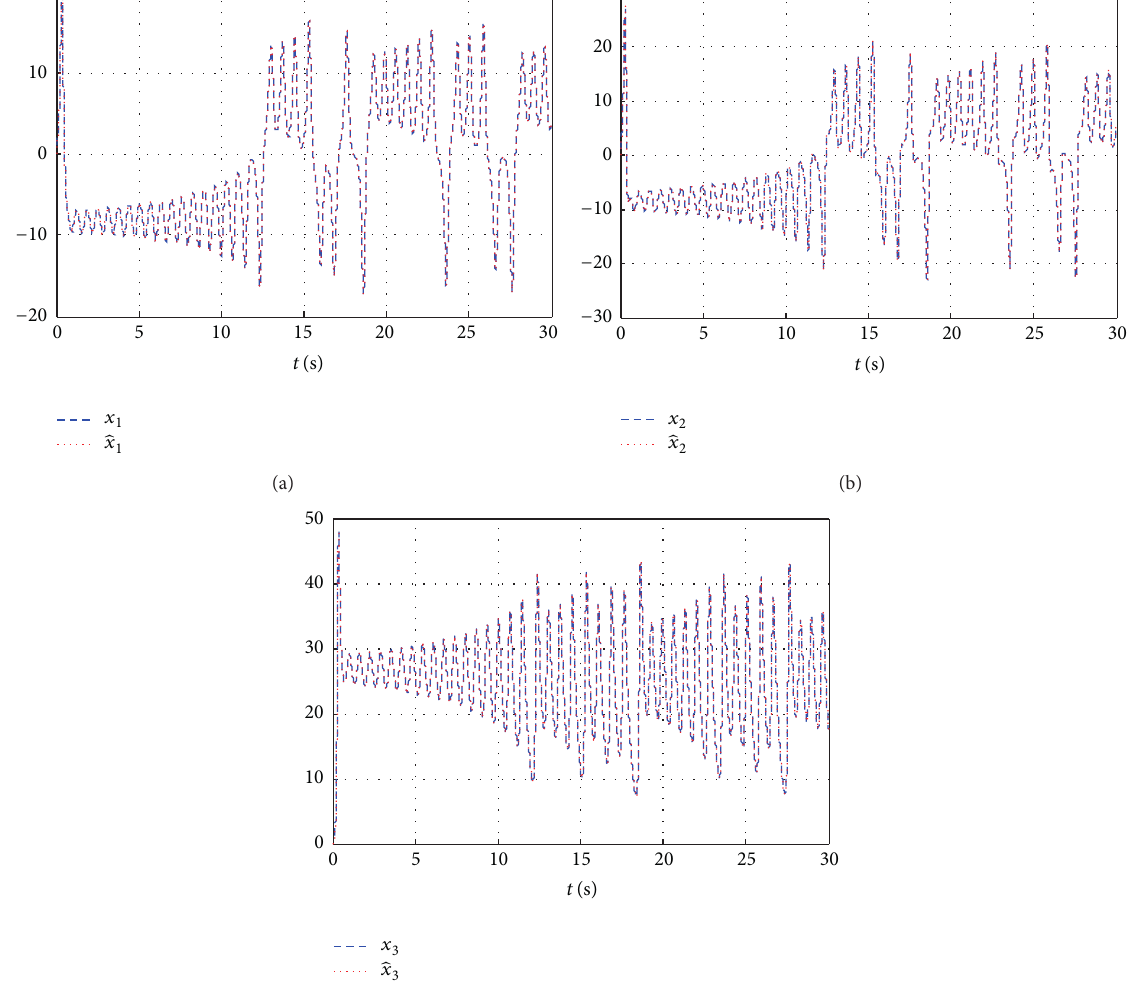
with the initial conditions 𝑥 0 = [ 1 1 1 ] ̂𝑥 0 = [ 0 0 0 ] and with 𝜀 = 10 −3